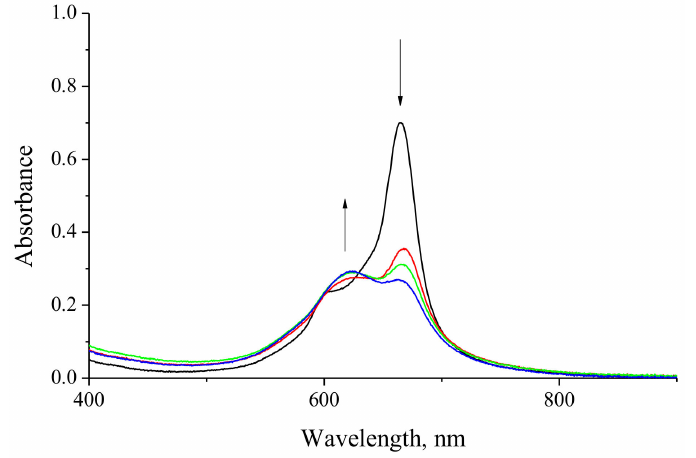
Figure 1. UV-Vis spectra of CoPc (2 × 10 − 5 M, black line) with addition of chitosan 0.01 mass% (red line), 0.015 mass% (green line) and 0.02 mass% (blue